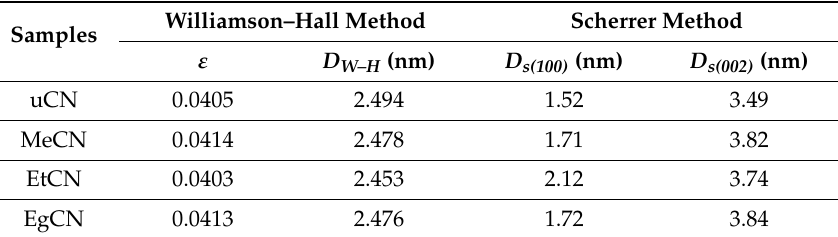
Figure 1. XRD patterns of mCN, uCN, MeCN, EtCN, and EgCN samples. Table 1. Lattice strain ( ε ) and crystallite size ( D W–H and D s ) obtained from Williamson–Hall and Scherrer methods for uCN, MeCN, EtCN, and EgCN